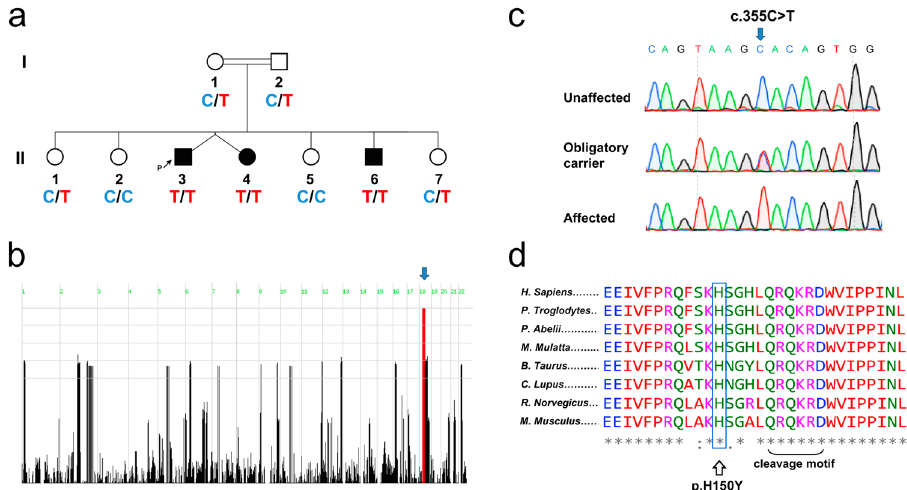
Fig. 1 Pedigree and CDH2 mutation. a Pedigree of the consanguineous kindred studied. Beneath each individual is the allele corresponding to the CDH2 mutation. C and T denote the WT or mutant nucleotide, respectively. b Homozygosity scores. Genome-wide single nucleotide polymorphism (SNP) distributions were collected for all nine family members by bead-chip (>750 k/sample). The distribution of homozygous regions in the genome was determined using HomozygosityMapper (http://www.homozygositymapper.org/). Genomic regions are ordered by chromosome (green numbers). The blue arrow indicates the single homozygous locus on chromosome 18 shared by affected individuals. c Sanger sequencing. Through whole-exome sequencing, a single homozygous variant was found within the segregating locus: c.355 C > T in CDH2. CDH2 sequencing results of an unaffected individual (II:2), an obligatory carrier (I:1), and an affected individual (II:3) are shown. d Protein MSA. To demonstrate evolutionary conservation within the vicinity of mutated p.H150Y residue, eight representative CDH2 orthologs were selected for MSA. The recognition motif RXK/R-R is located approximately fi ve residues downstream of the identi fi ed site of mutation. MSA, multiple sequence